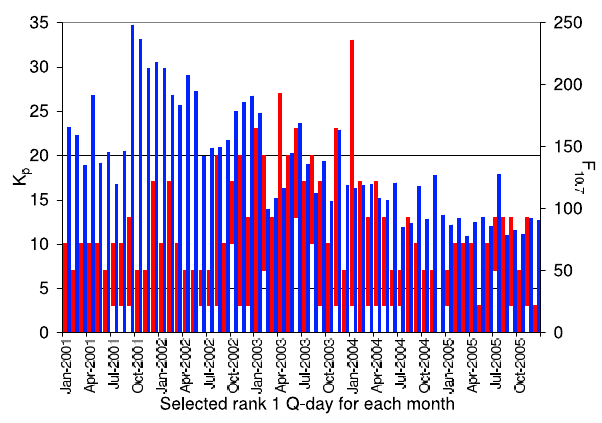
Fig. 1. Activity indices including the K p range (red) and F 10 . 7 (blue) for the selected rank 1 Q-days of each